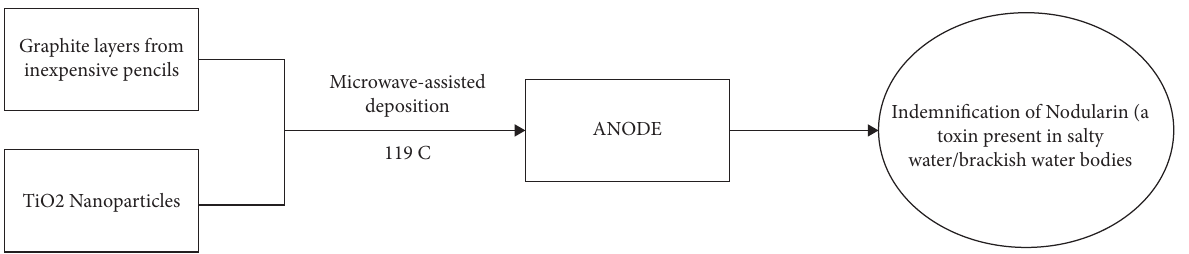
Figure 15: Remediation of nodularin using microwave-assisted deposition-based